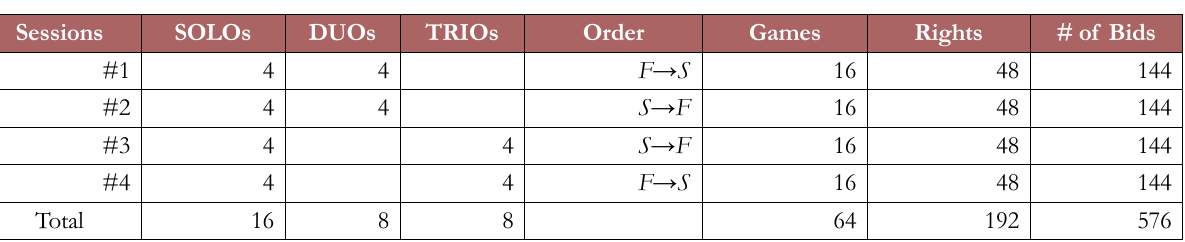
Table 2. Description of the in-situ